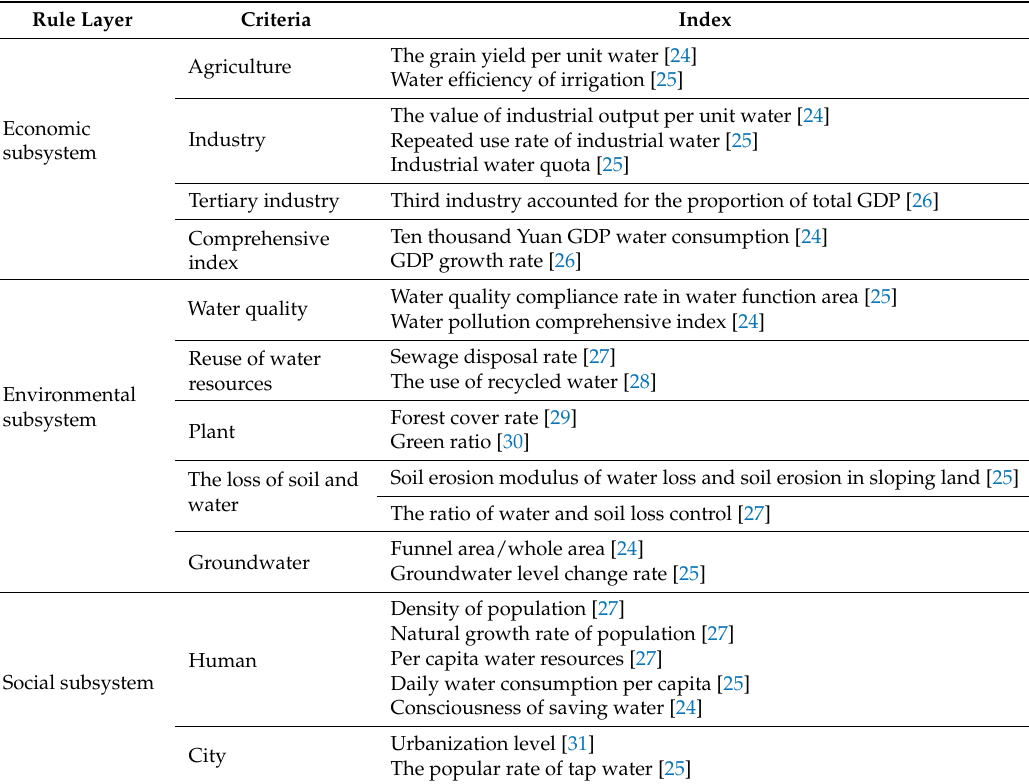
Table 1. Three subsystems, criteria, and preliminary